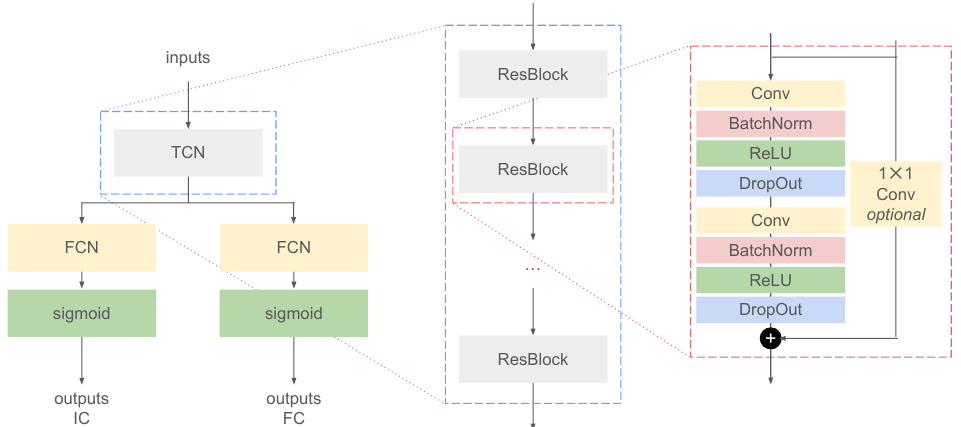
Figure 2. The generic model architecture of the deep learning model to predict initial contacts (ICs) and final contacts (FCs). The inputs are the accelerometer and gyroscope data from a single inertial measurement unit, which are fed to a temporal convolutional network (TCN) ( left ). The TCN consisted of repeating residual blocks (ResBlocks) with exponentially increasing dilation factor (middle). Each ResBlock was built from two sequences of a convolutional layer (Conv), batch normalization layer (BatchNorm), a rectified linear unit activation layer (ReLU), and a dropout layer (DropOut) ( right ).